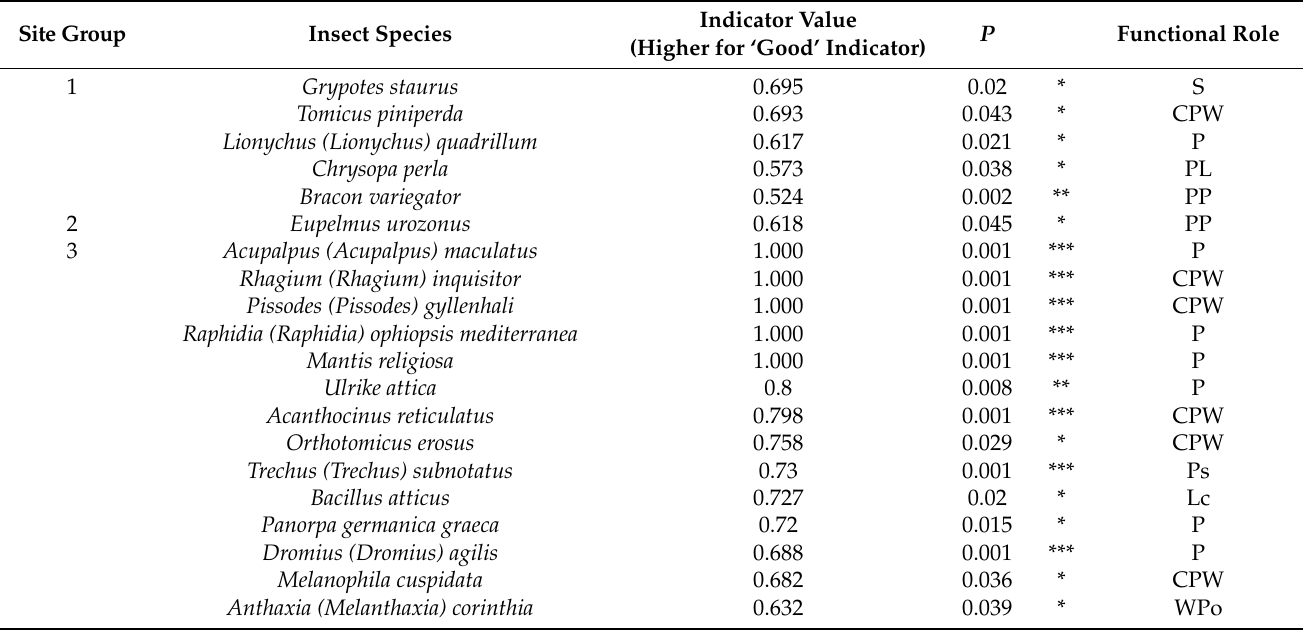
Table A1. Insect species that are significant indicators of plot groups. Eighty species out of 140 are significant indicators and are shown in this table. The probability of having a smaller indicator value is 0.05 or smaller. The last column describes the functional role of each insect species. The explanations of symbols are given in Figure